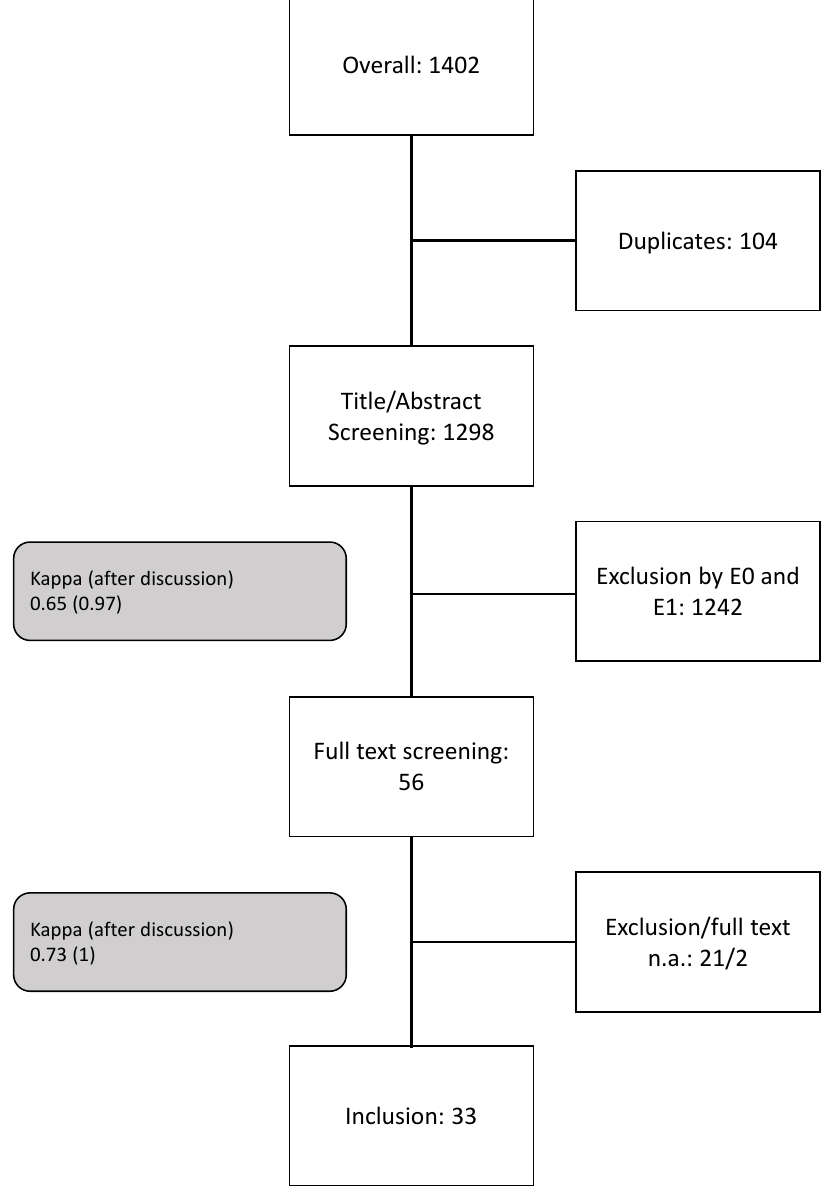
Figure 1. Overview of the screening process for selecting the studies for the systematic review. The grey boxes indicate the Cohen’s Kappa values before and after (in brackets)